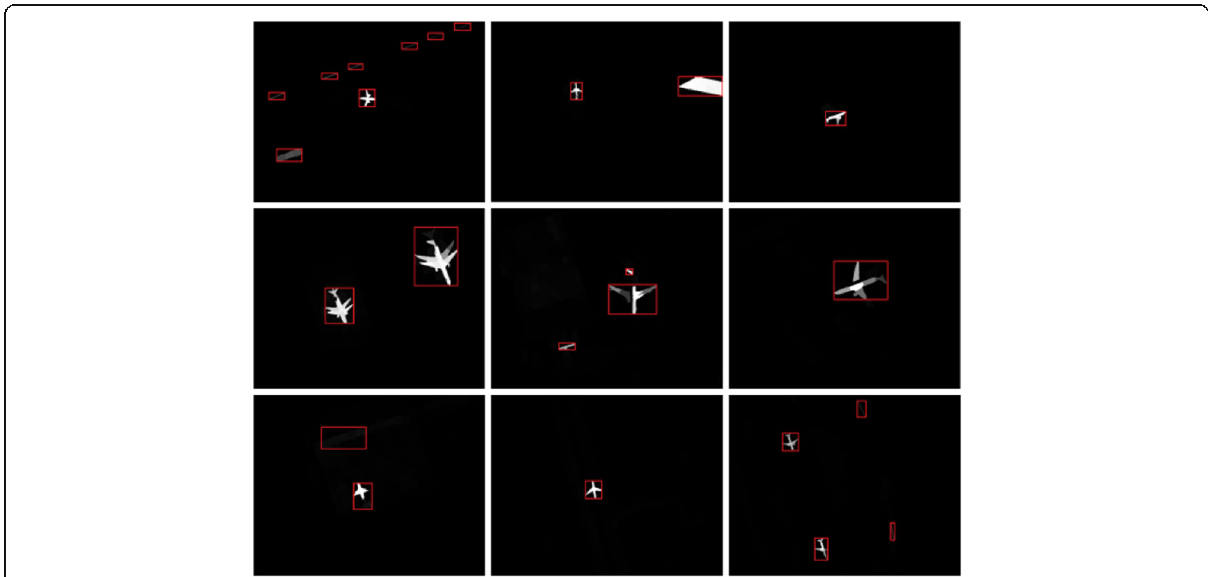
Fig. 6 The bounding box of saliency image. If the bounding boxes are overlapped, these bounding boxes are merged and remain the maximum